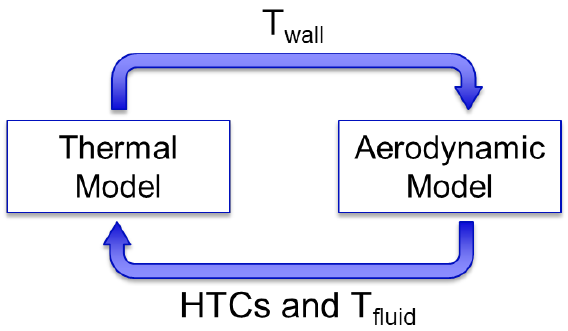
Figure 1. Simplified coupling process. T wall is the temperature of the surfaces while T fluid is the reference air temperature next to the surfaces.